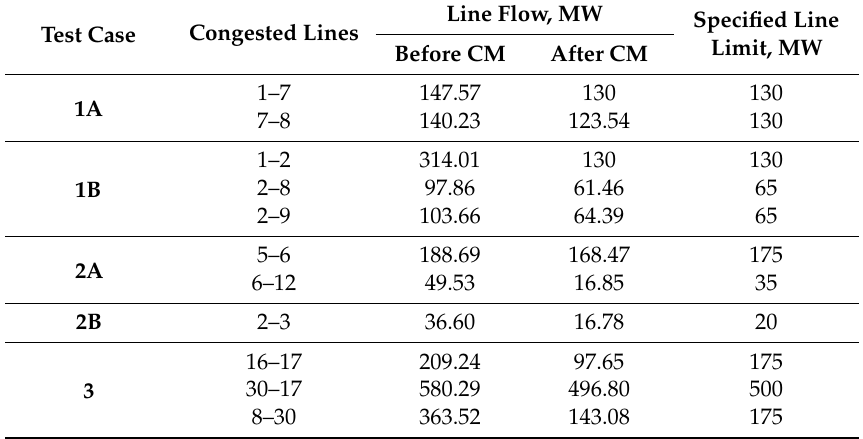
Table 2. Details of congested line flow for different test systems. CM: congestion